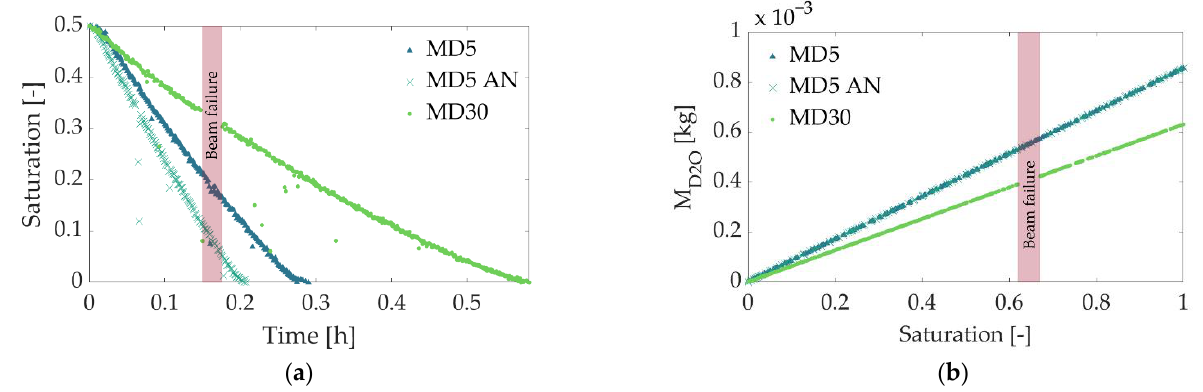
Figure 7. ( a ) Overall saturation over time and ( b ) corresponding water content. The beam failure occurred in experiment 3 (MD30) and is marked by the red bar. occurred in experiment 3 (MD30) and is marked by the red